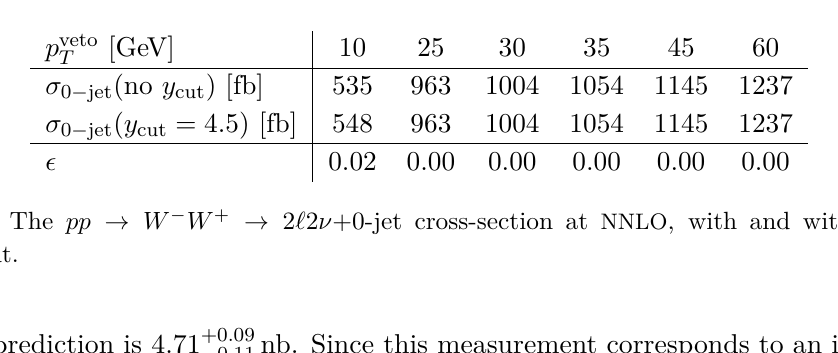
Figure 11 . Comparison of W -boson jet-vetoed predictions with the ATLAS [43] 8 TeV measurement. Shown are results at fixed-order, purely resummed and matched.